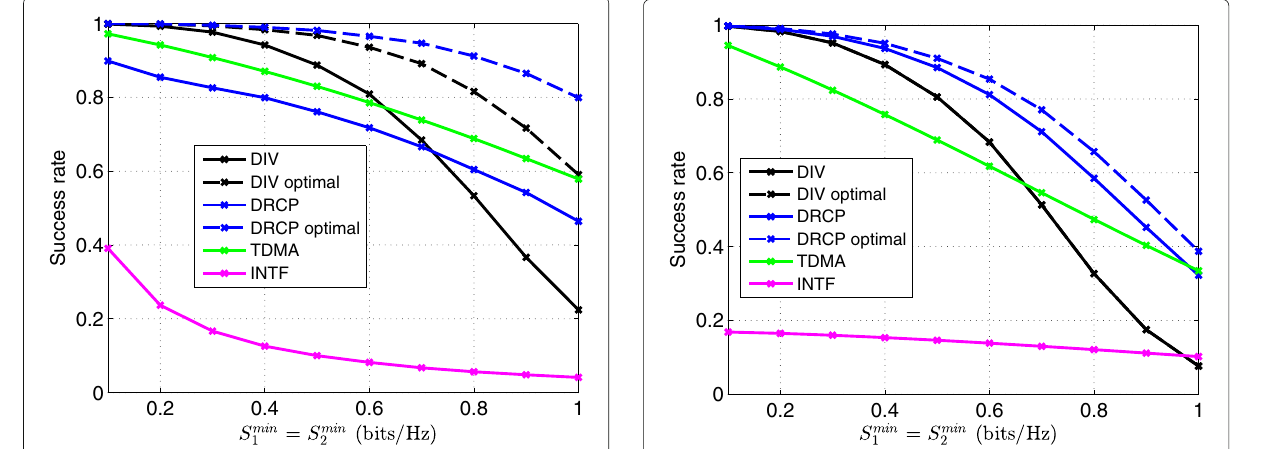
Fig. 10 Success rate of the studied approaches in the transmit power-dominated regime with equal average links